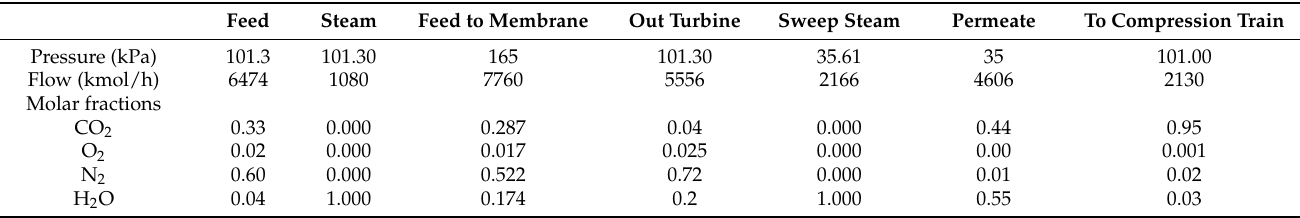
Table A1. Stream table for FTM capture process at 75 ◦